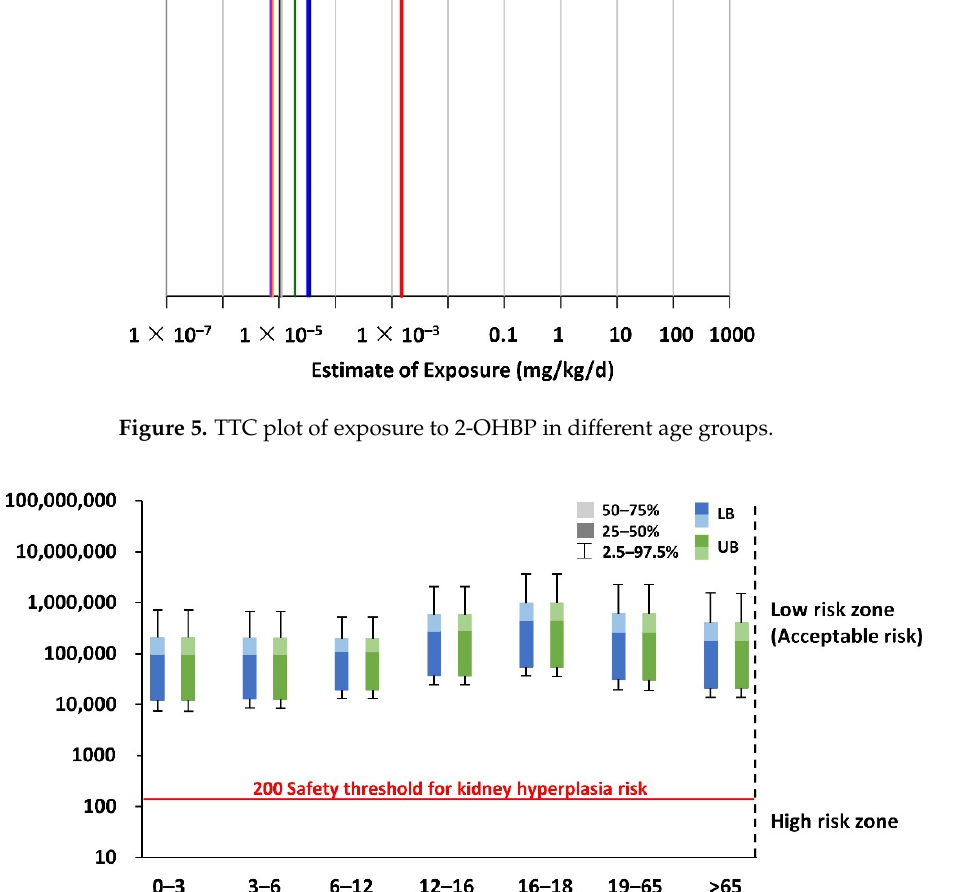
Figure 5. TTC plot of exposure to 2-OHBP in different age groups.